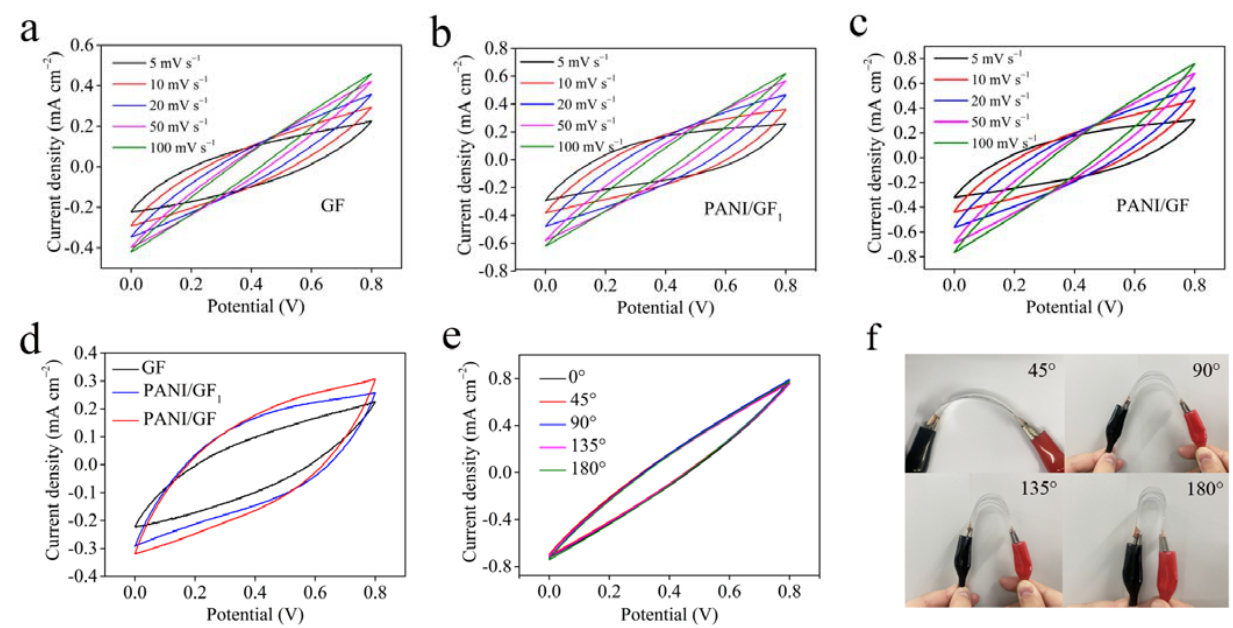
Figure 7. Cyclic voltammetry (CV) curves of ( a ) GF, ( b ) PANI/GF 1 and ( c ) PANI/GF at different scan rates of 5, 10, 20, 50 and 100 mV s − 1 ; ( d ) CV curves of GF, PANI/GF 1 and PANI/GF at 5 mV s − 1 ; ( e ) bending stability of PANI/GF under different angles at 100 mV s − 1 and ( f ) photograph of bending tests.